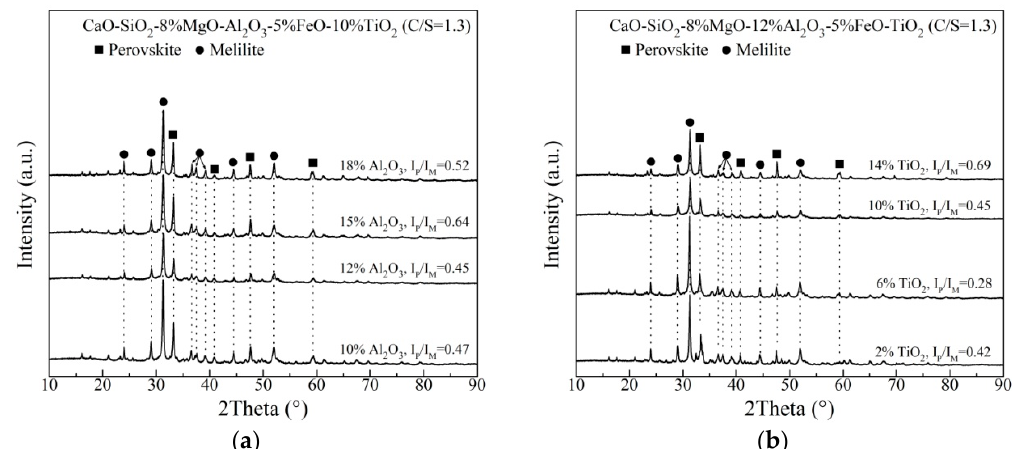
Figure 3. Analysis of the slowly cooled slag samples with ( a ) varying Al 2 O 3 content and ( b ) varying TiO 2 content.